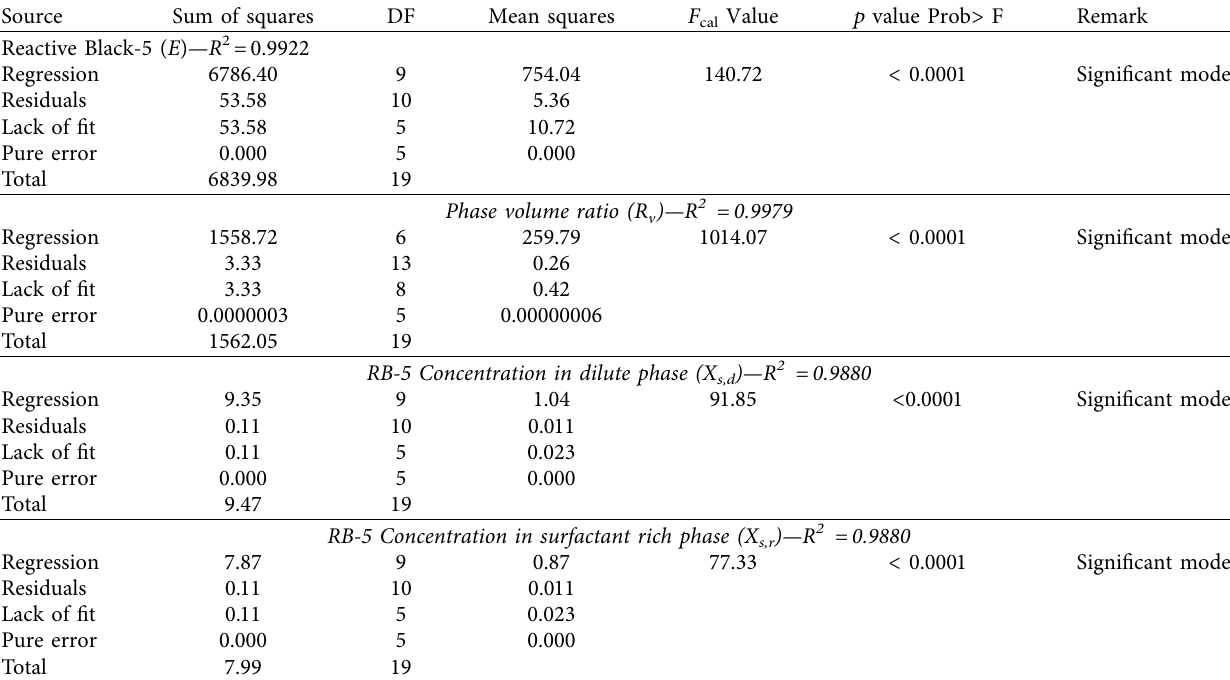
Table 3: Validity of dye extraction by